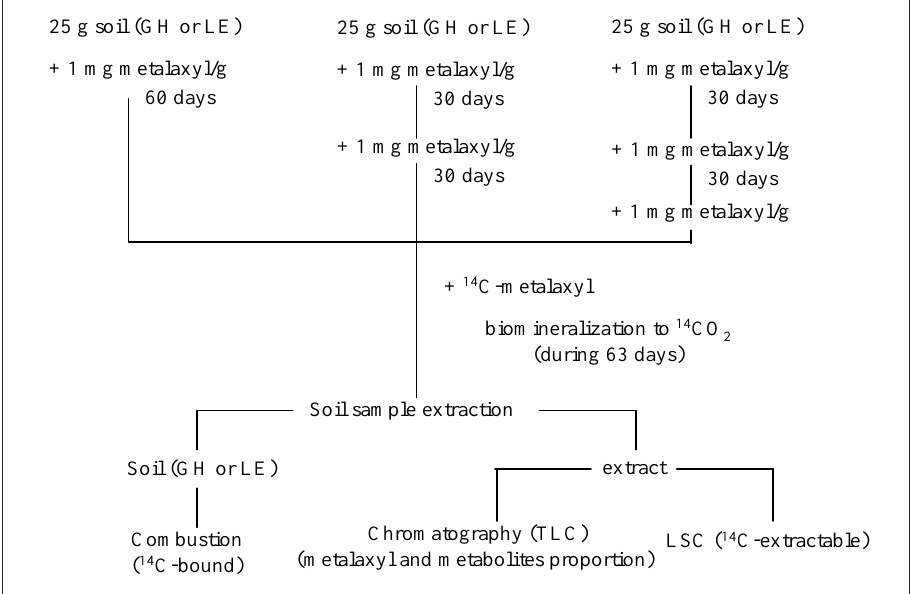
Figure 1. Diagram of the study on the behaviour of metalaxyl in a commercial formulation after one, two and three applications in Gley Humic (GH) and Dark Red Latosol (LE).